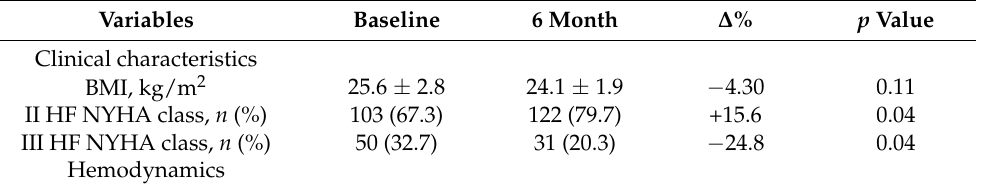
Table 2. Comparison of variables between baseline and 6 months after the administration of